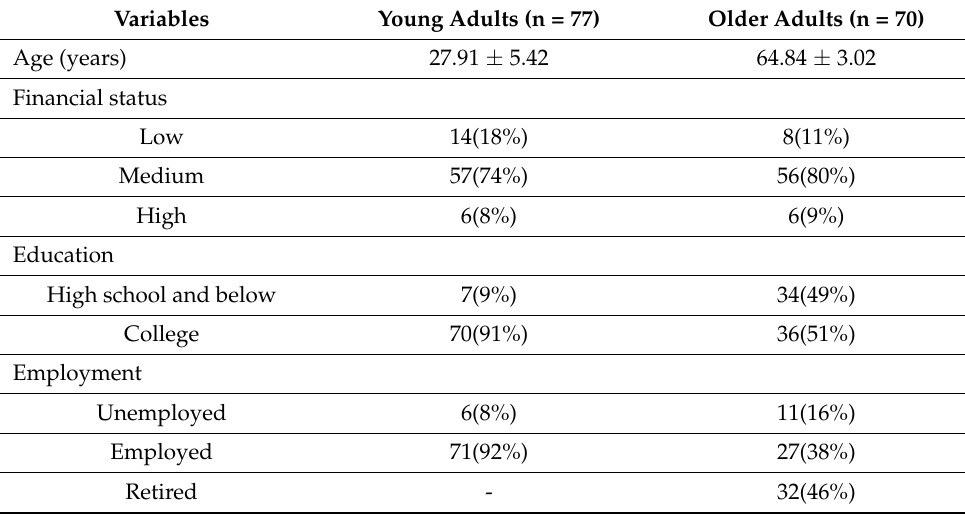
Table 1. Demographic characteristics of the study’s sample.